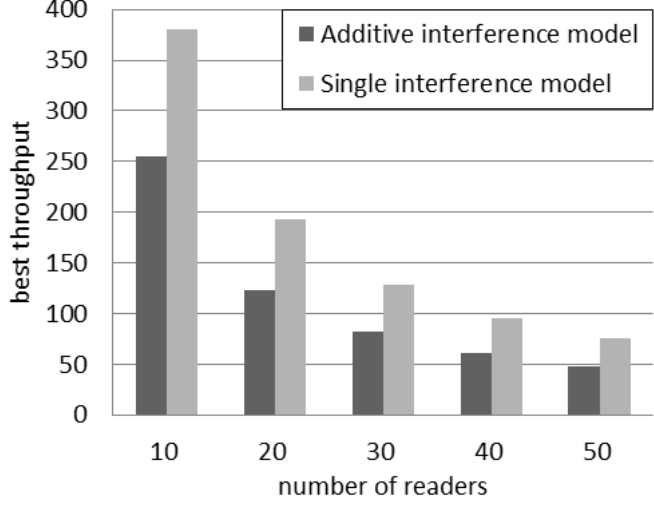
Figure 3. Best throughput in the probabilistic interrogation